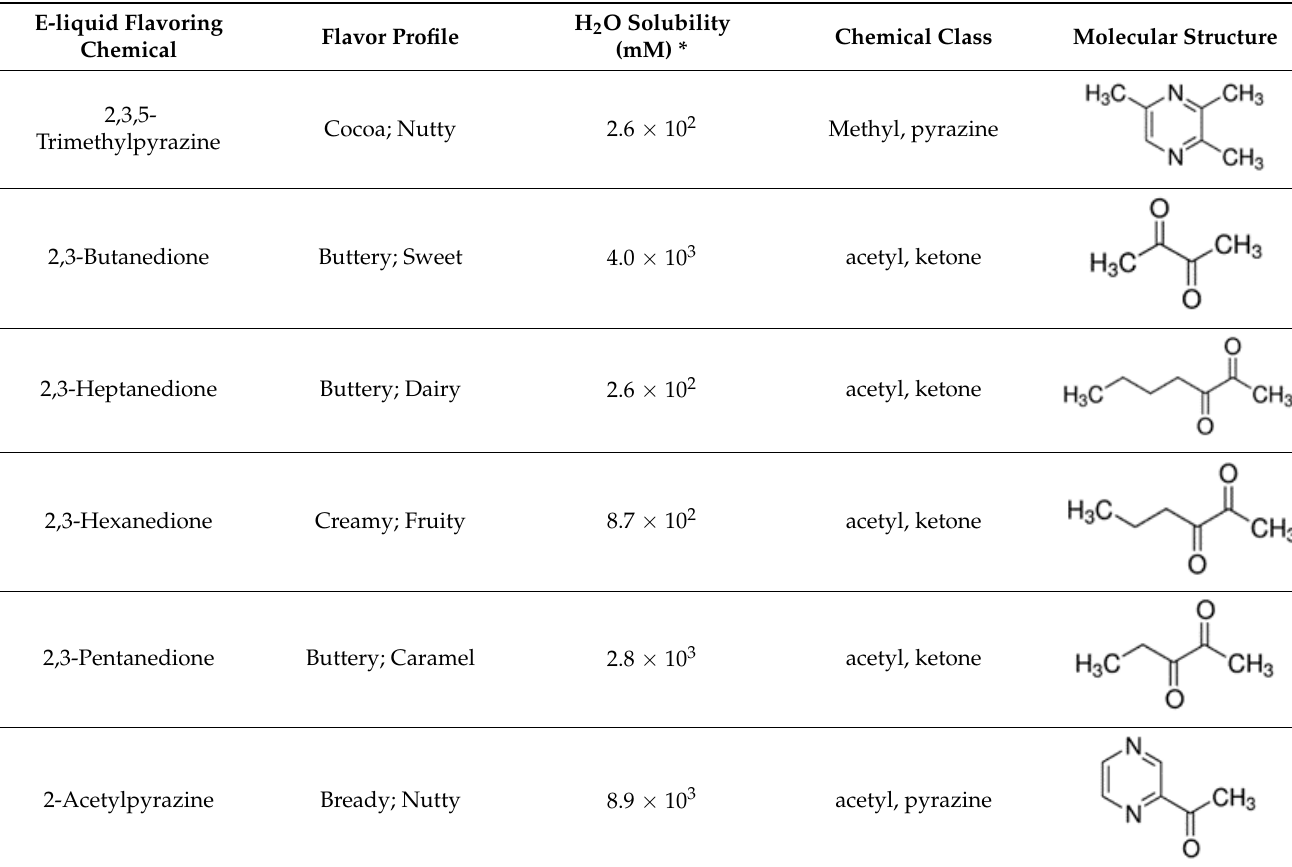
Table 1. List of flavoring chemicals and their characteristics.